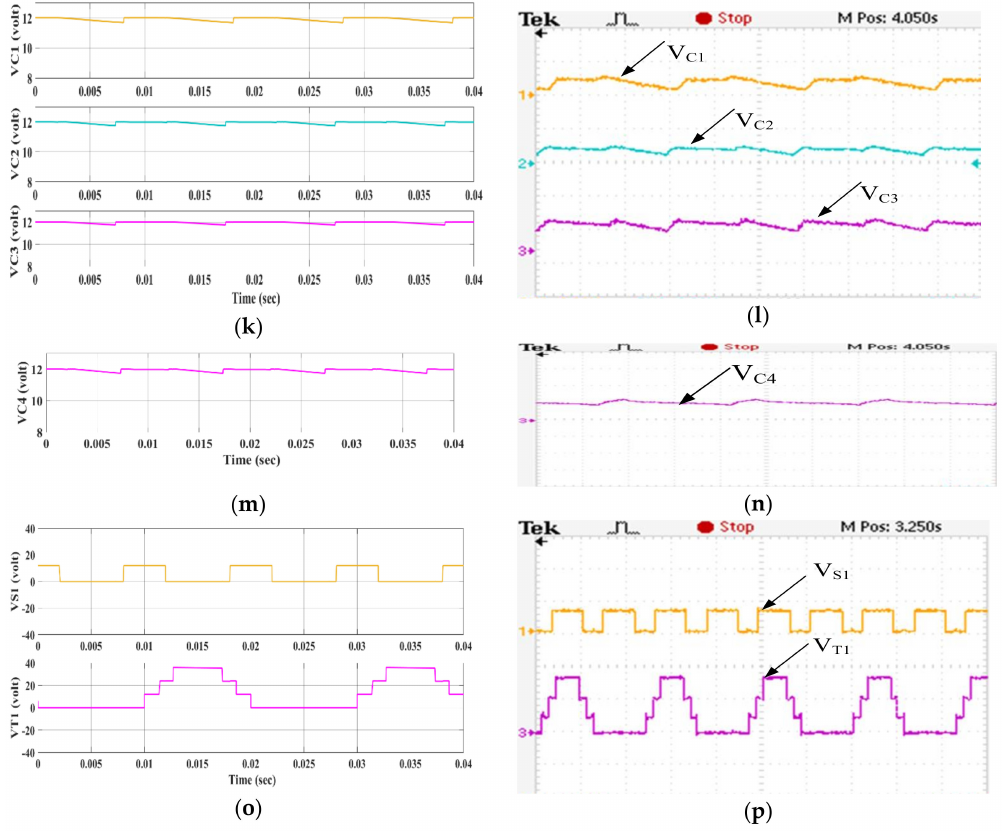
Figure 14. ( i ) and ( j ) Output Voltage (20.5 V / diV) and output current ( × 100) (0.205 A / diV). ( i – l ) Voltage